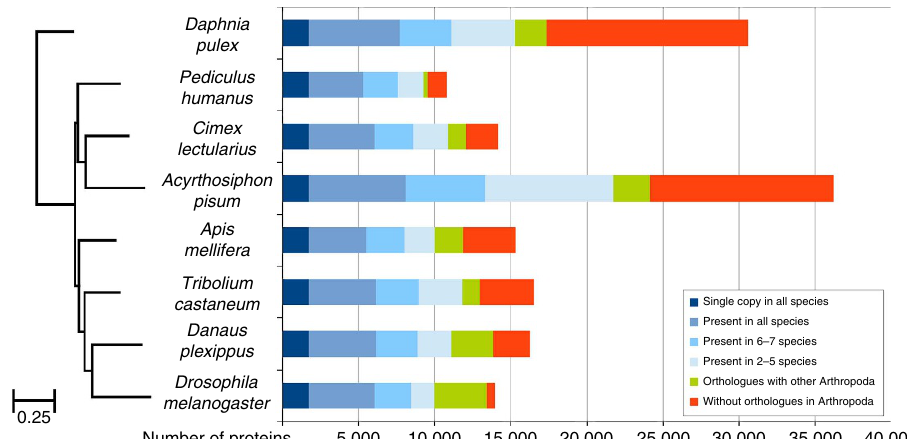
Figure 1 | Phylogenetic placement and orthology comparison among Cimex lectularius and other arthropod species. The phylogenetic analysis places C. lectularius as a sister species to another hemipteran, Acyrthosiphon pisum . The phylogeny is built using RAxML and it is based on the 1,734 single-copy orthologues that are present in all eight species. All nodes in the phylogenetic tree have 100% bootstrap support, while the branch length unit is substitutions per site. There are 1,734 genes that are present as single copy in all eight species tested. Another 4,187 of the C. lectularius genes are found in varying copy number in the other seven species, while 2,433 are found in the majority of species (that is, in 5–7 species) and 2,153 genes are found in Z 2 species (that is, in 2–4 species). Moreover, 1,147 genes have an orthologue in an arthropod other than the selected seven species. Last, 2,285 genes are lineage specific and do not have an orthologue in any other arthropod